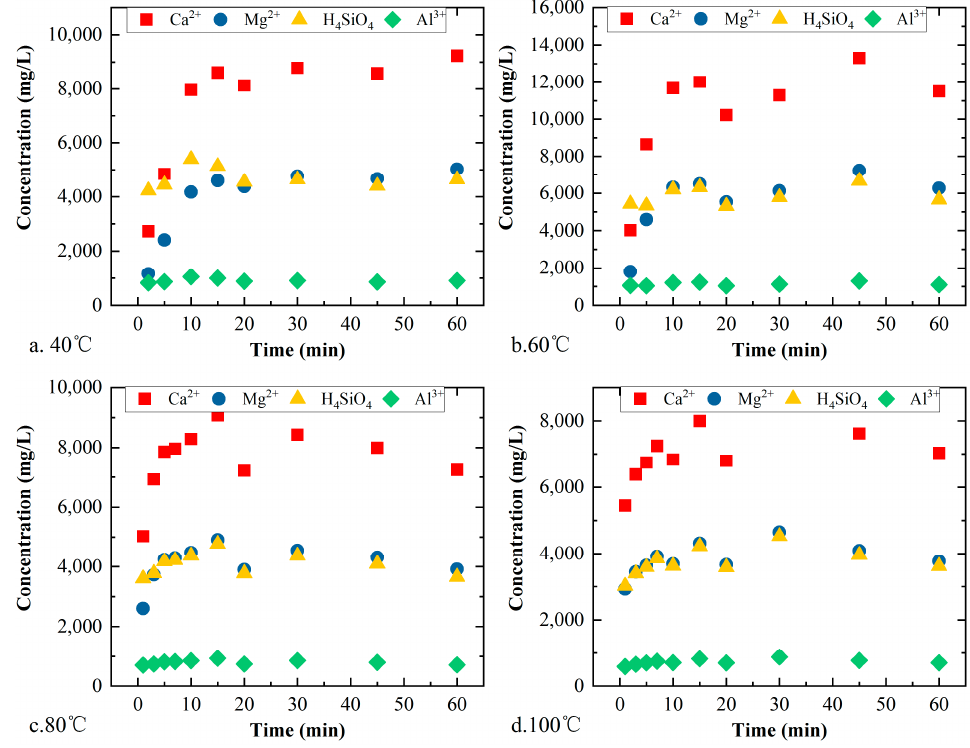
Figure 7. Ion concentration of acid after the reaction of core R1 at ( a ) 40 °C; ( b ) 60 °C; ( c ) 80 °C; ( d ) 100 °C. ( d ) 100 ◦